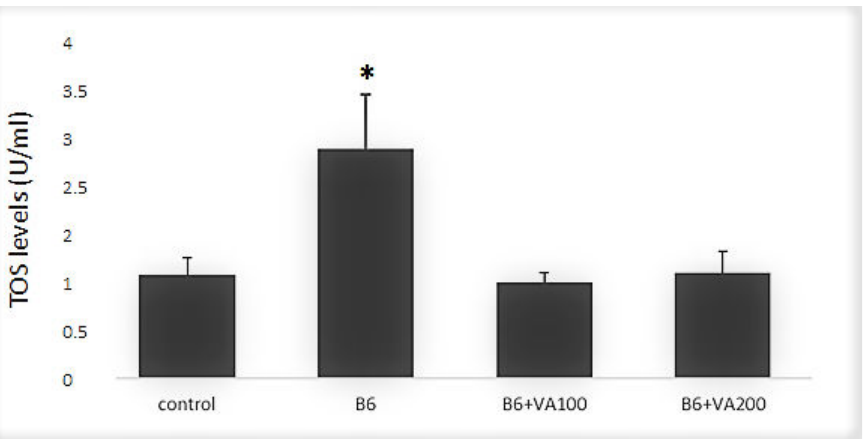
Figure 2. The effects of benomyl and benomyl accompanied by two concentrations of VA (100 and 200 µ M) on the total oxidant status (TOS) levels of the cells. B6: exposure to 6 µ M benomyl; VA100: exposure to 100 µ M valerenic acid; VA200: exposure to 200 µ M valerenic acid (* statistically significant difference compared to the control).